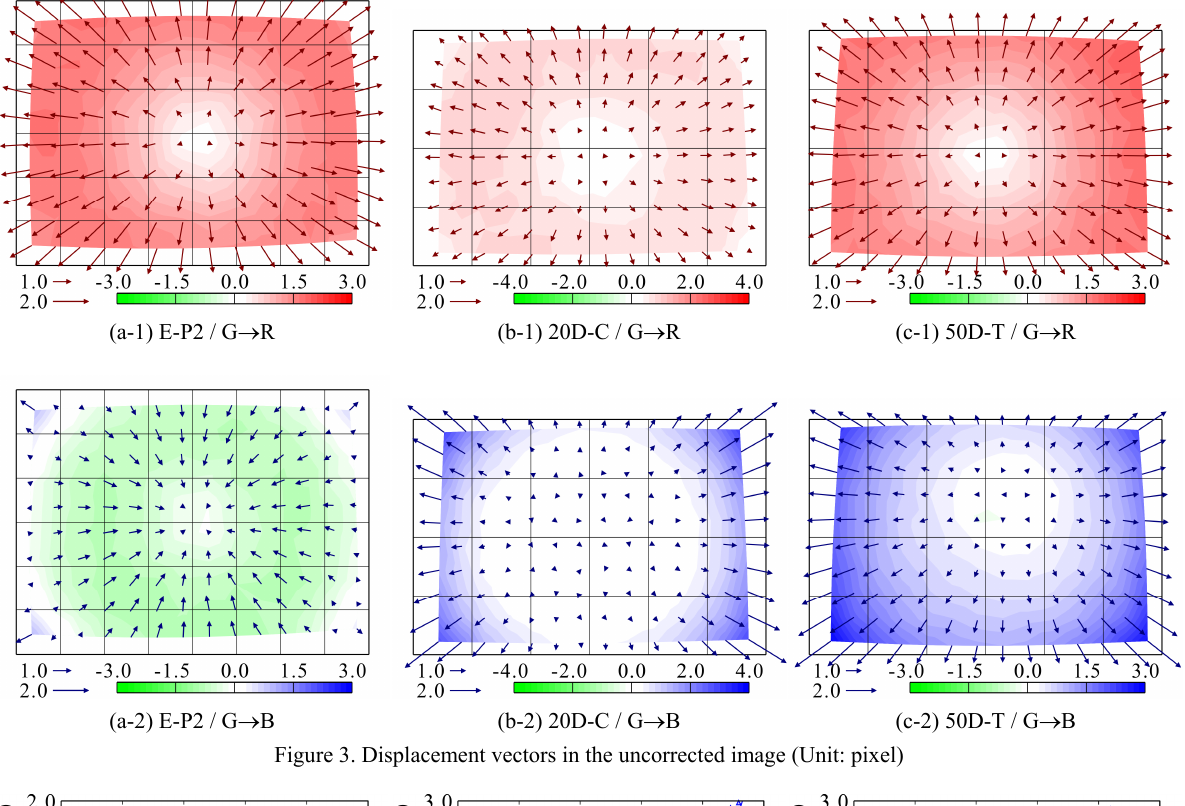
Figure 3. Displacement vectors in the uncorrected image (Unit: pixel)